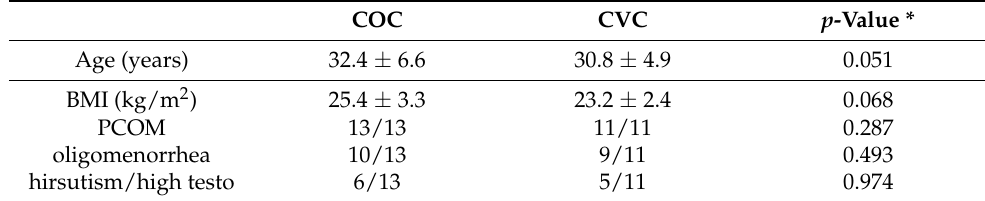
Table 1. Baseline characteristics of the study population. COC CVC p -Value * Age (years) 32.4 ± 6.6 30.8 ± 4.9